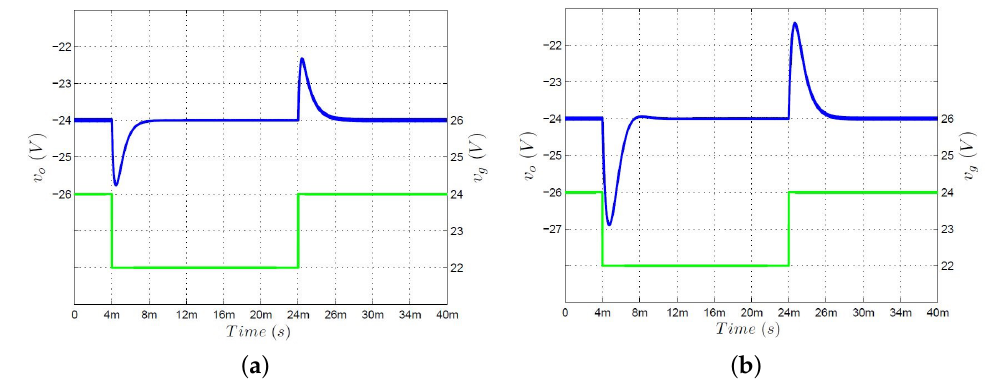
Figure 7. Simulated response of the buck-boost converter under input voltage transients of 2 V with the LMI-Fuzzy controller ( F LMI − Fuzzy ) and LMI robust controller ( F LMI ). ( a ) Voltage response v o with F LMI − Fuzzy . ( b ) Voltage response v o with F LMI